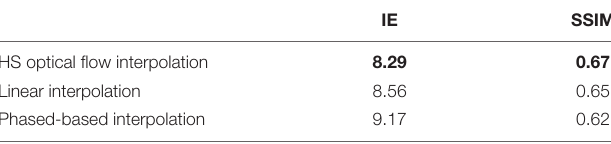
Bold values highlight the highest